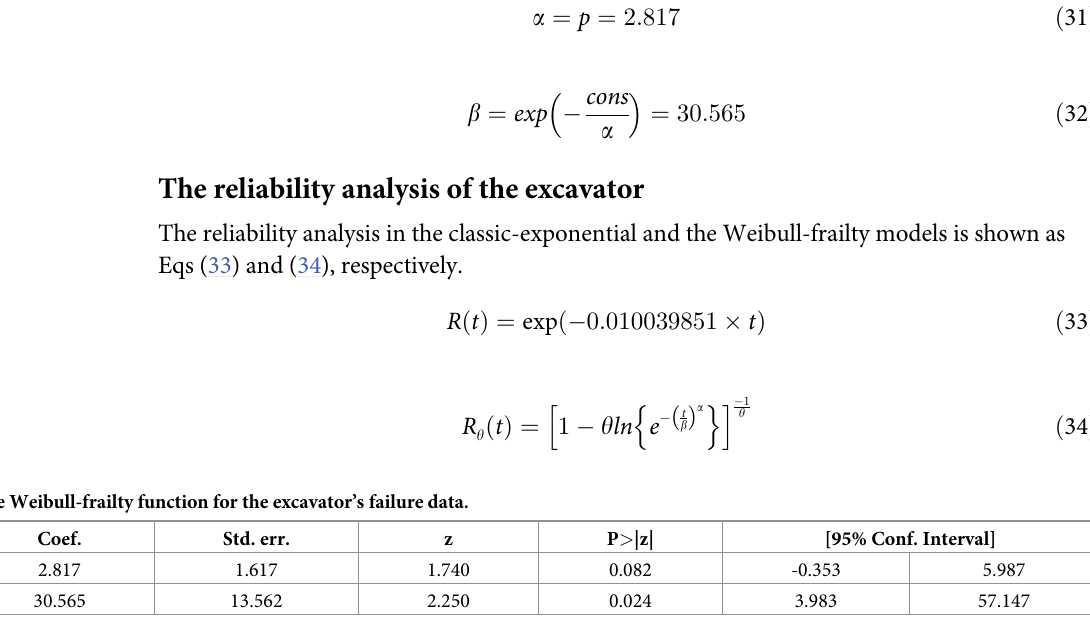
Also, Table 4 presents the parameters of the classical Weibull-frailty model for the excava- tor’s failure data. From Table 4 and Eq (7), θ or the variance of the gamma function equals to 3.575 for the reliability analysis in frailty model. Therefore, the only remaining part of the reli- ability analysis is to determine the Weibull function. According to the p-shape parameter and the constant value (cons.), Eq (30) provides the results of Weibull function, as one-parameter Weibull.